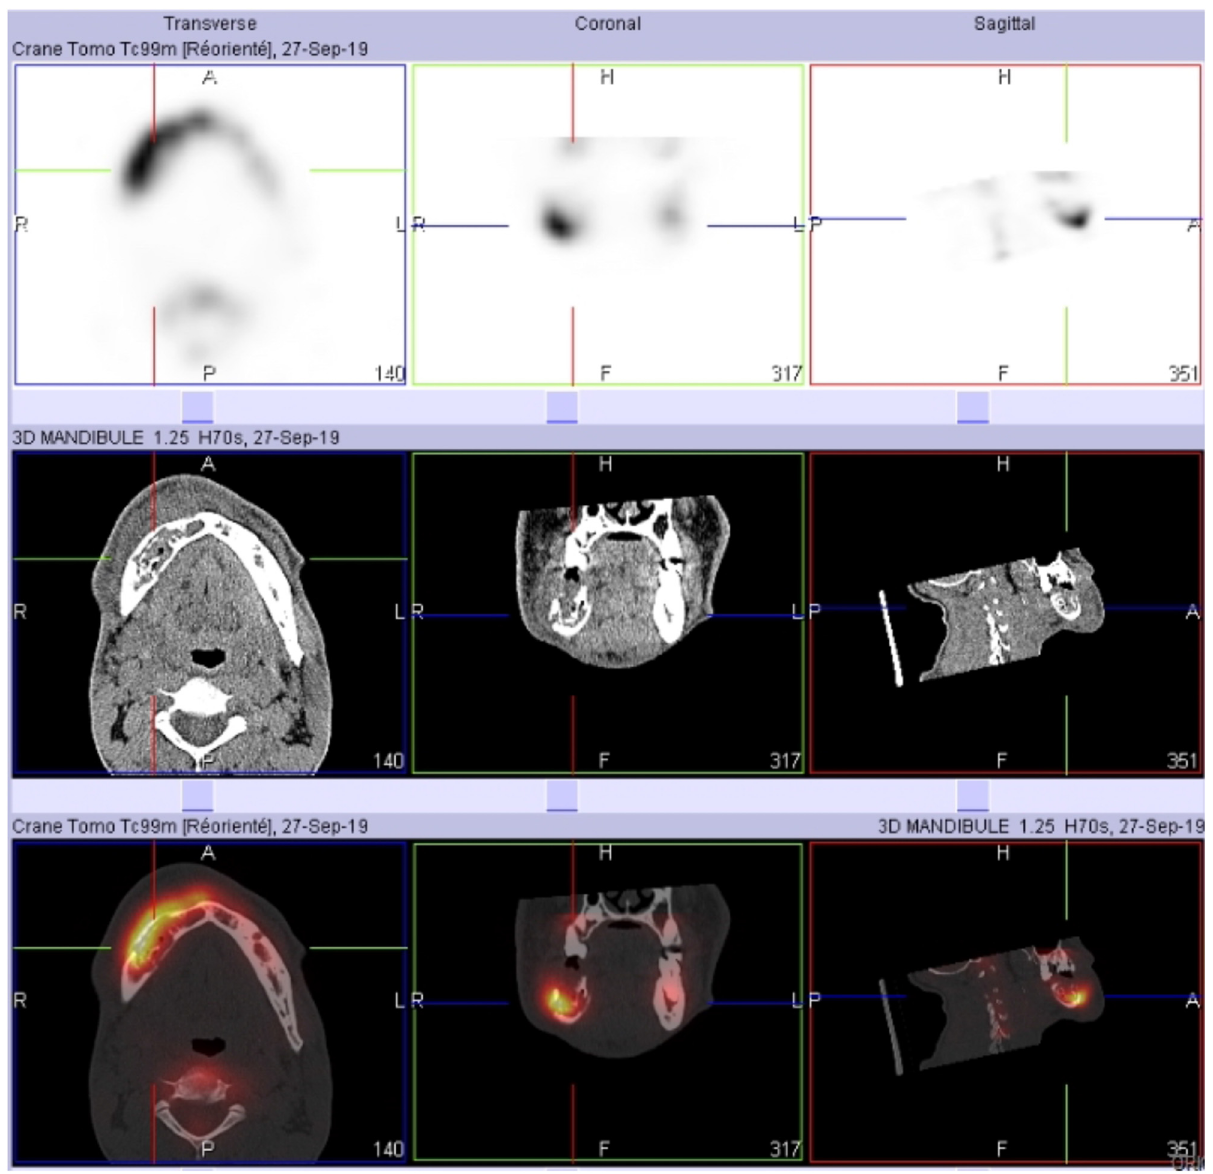
Fig. 3. Positron emission tomography: hypo fi xation of the cortex of the mandible body at the site of the lower right fi rst molar underlying